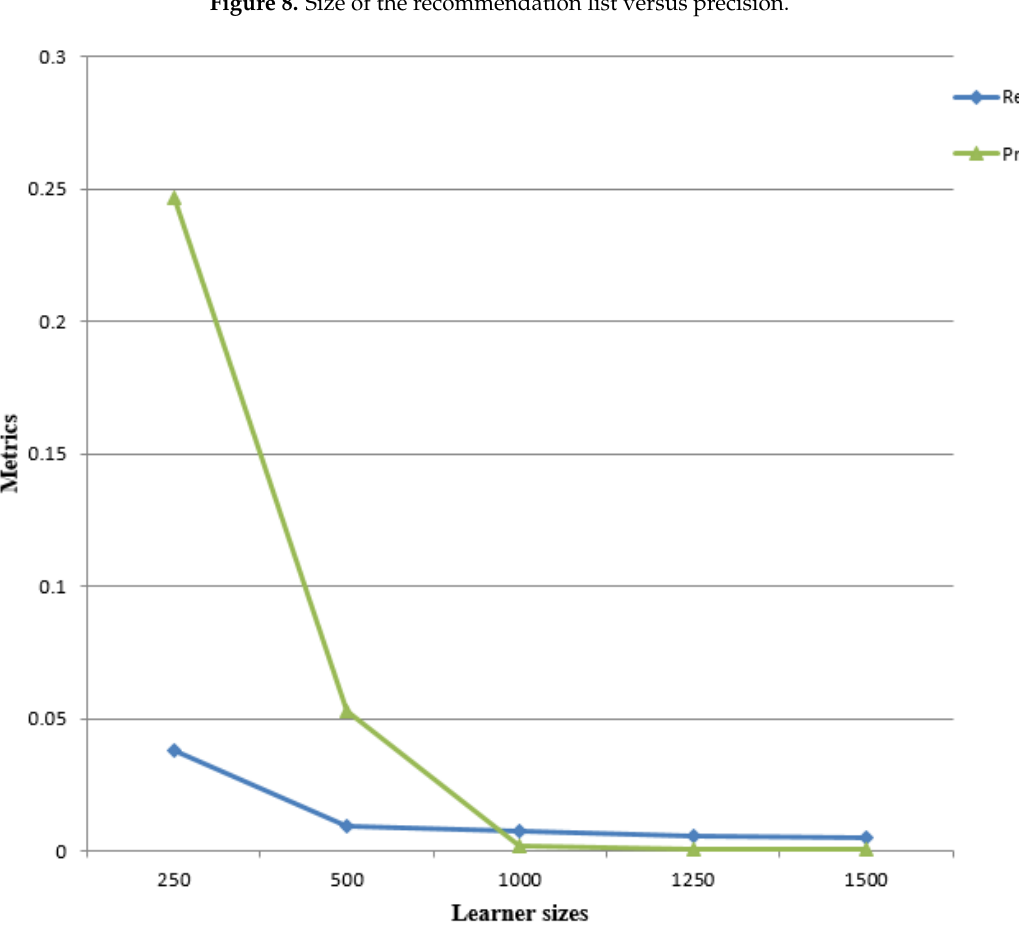
Figure 9. Precision and recall for different learner group sizes.